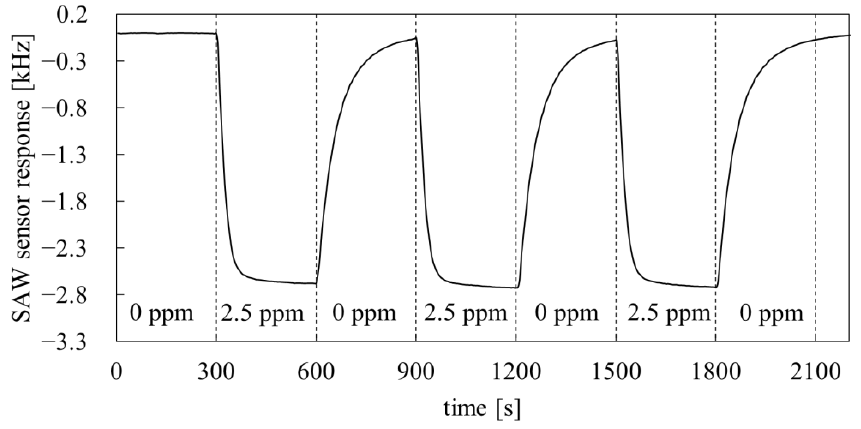
Figure 10. The real-time PMFOS sensor response recorded during alternating exposure to a gas stream with a DMMP concentration of 2.5 ppm and dry synthetic air at 30 °C.